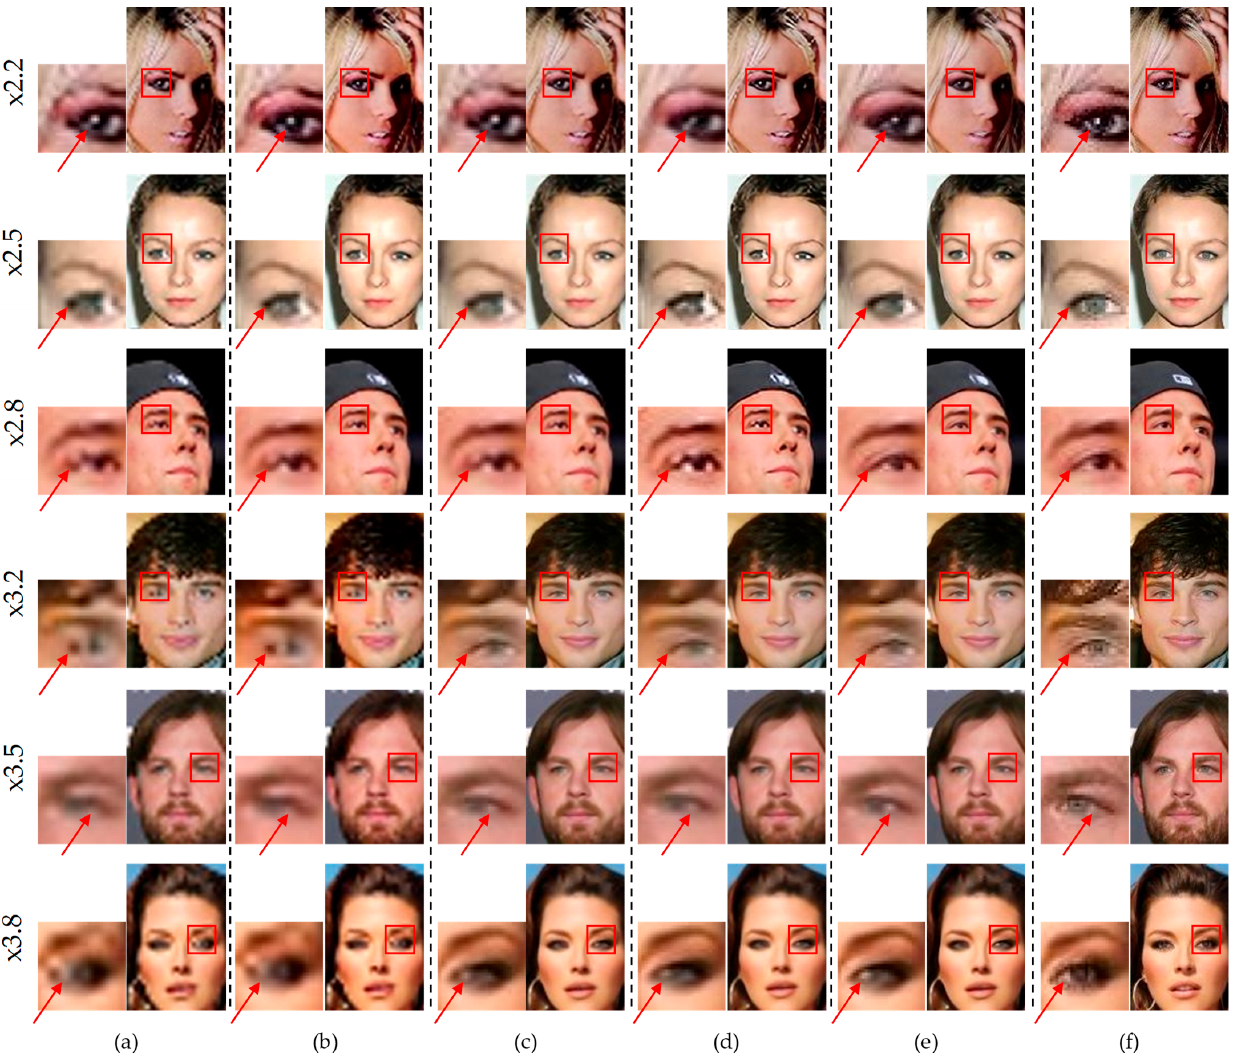
Figure 10. Comparison between our H 2 A 2 -SR results and Meta-SR results: ( a ) bicubic results; ( b ) DRN + Meta-SR results; ( c ) DRN + Meta-SR* results; ( d ) DRN + expanded results in DCT; ( e ) DRN + H 2 A 2 -SR results; ( f ) high-resolution image.